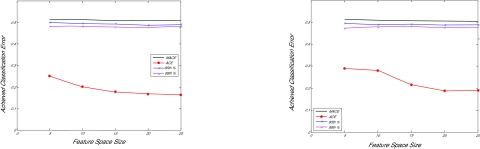
PACE analysis using a SVM-based classifier using the J5 scoring criterion, with a 0.6 MAC threshold. Left Panel: performance without peak selection. Right panel: performance with peak selection.